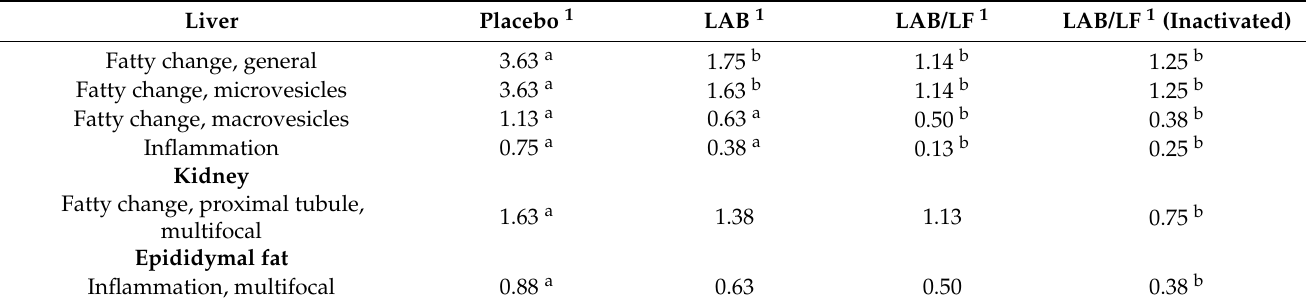
Figure 4. Histopathological evaluation of fatty livers in individual obese mice supplemented with a placebo or one of three probiotic mixtures. The groups are defined in the legend of Table 1. Placebo group (A1 to A8, n = 8); LAB group (B1 to B8, n = 8); LAB/LF group (C1 to C8, n = 8); LAB/LF (inactivated) group (D1 to D8, n = 8). The amount of fat in the liver was graded from 0 to 4 as explained in Figure 1. Table 2. Mean score of histopathological changes in the fatty lesions in the liver, kidney, and epididymal fat in DIO mice supplemented with one of four treatments.